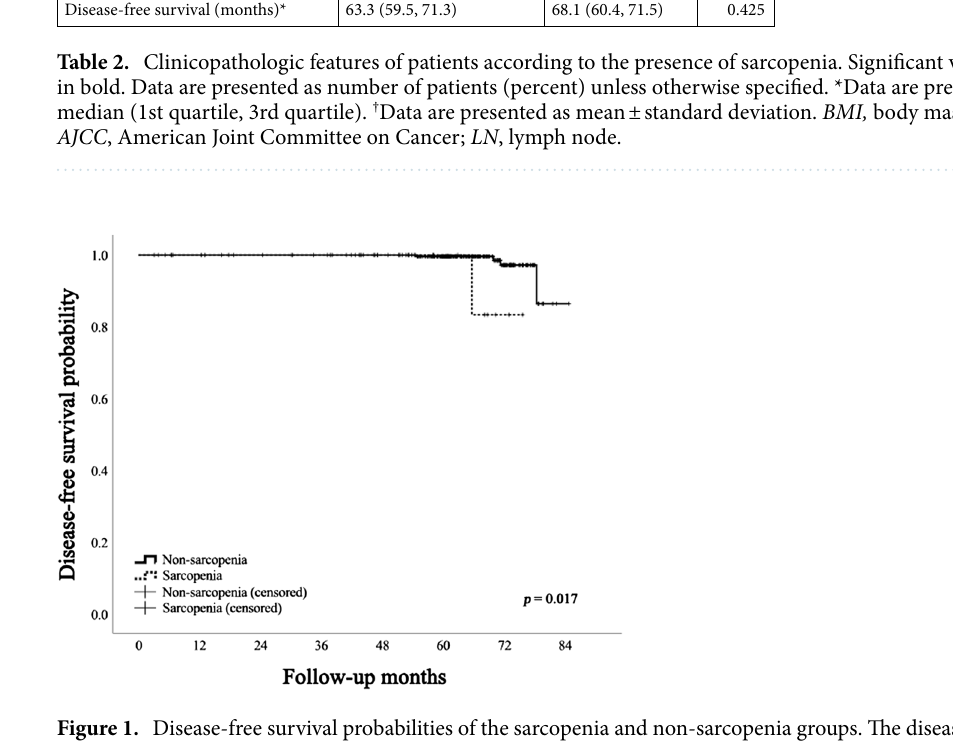
Figure 1. Disease-free survival probabilities of the sarcopenia and non-sarcopenia groups. The disease-free survival probability was lower in the sarcopenia group compared to the non-sarcopenia group, with statistical